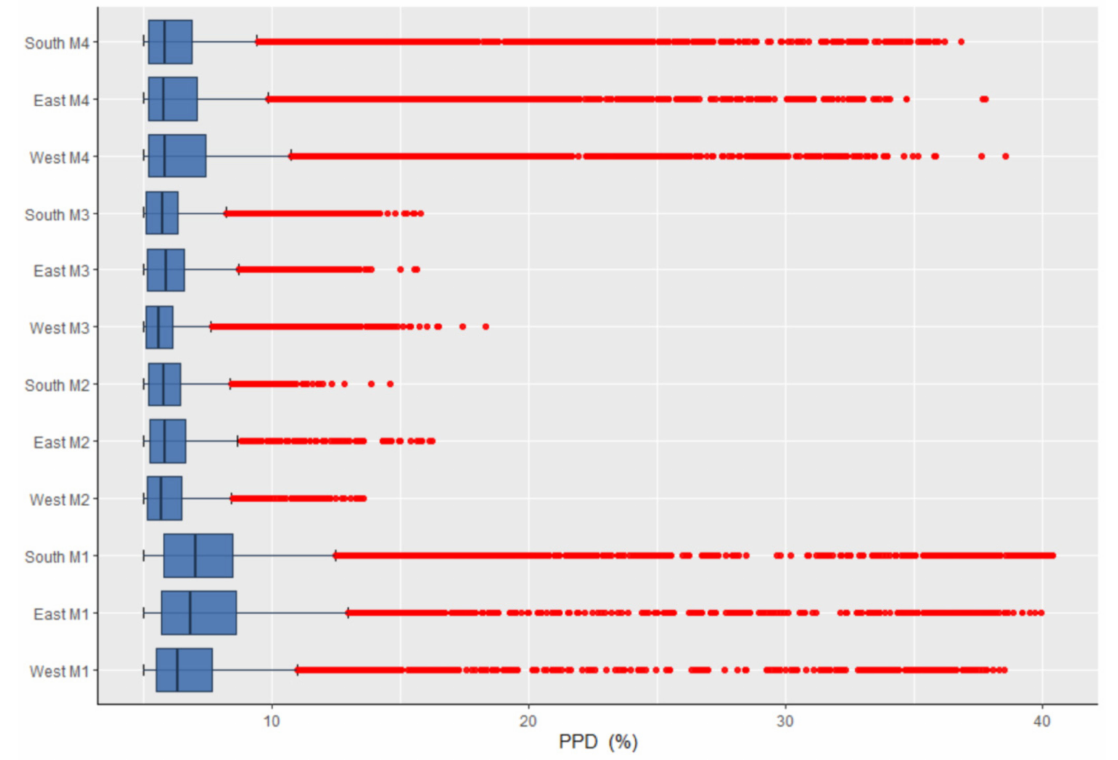
Figure 3. PPD values for different areas (south, east, and west) and different